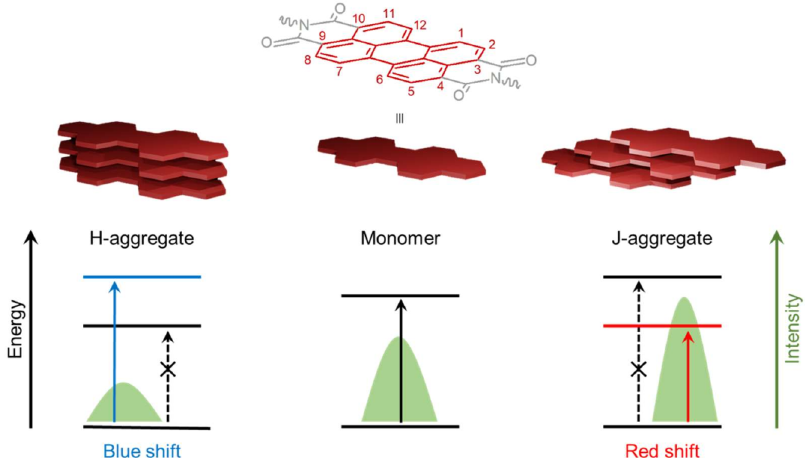
Figure 1. Molecular structure of PDI with the 12 positions of the perylene core. Arrangements of H- (left) and J- (right) aggregates resulting from the self-assembly of PDI monomers (center) with the corresponding effects on fluorescence emission spectra and electronic π – π * transitions. Full arrows indicate the permitted transitions and dashed arrows the forbidden